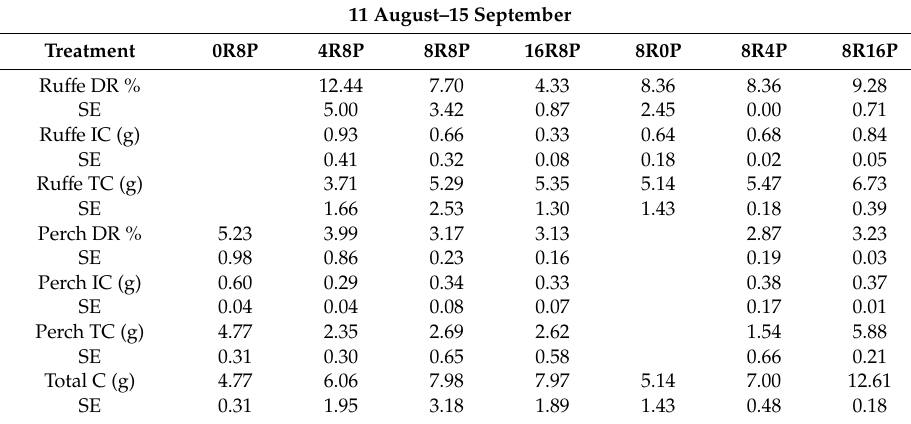
Table 2. Estimates of average daily food consumption (mean and 1SE) by ru ff e (R) and yellow perch (P) during the second (1997) experiment, based on bioenergetics modeling. Daily ration (DR) is reported as percent wet mass and daily individual (IC) and total (TC) consumption (means for each treatment) are reported in grams wet mass per day. Standard errors (SE) are based on two replicates (mesocosms) of each treatment except for those cases with no SE (-; n = 1) and 8R8P in September to October ( n =